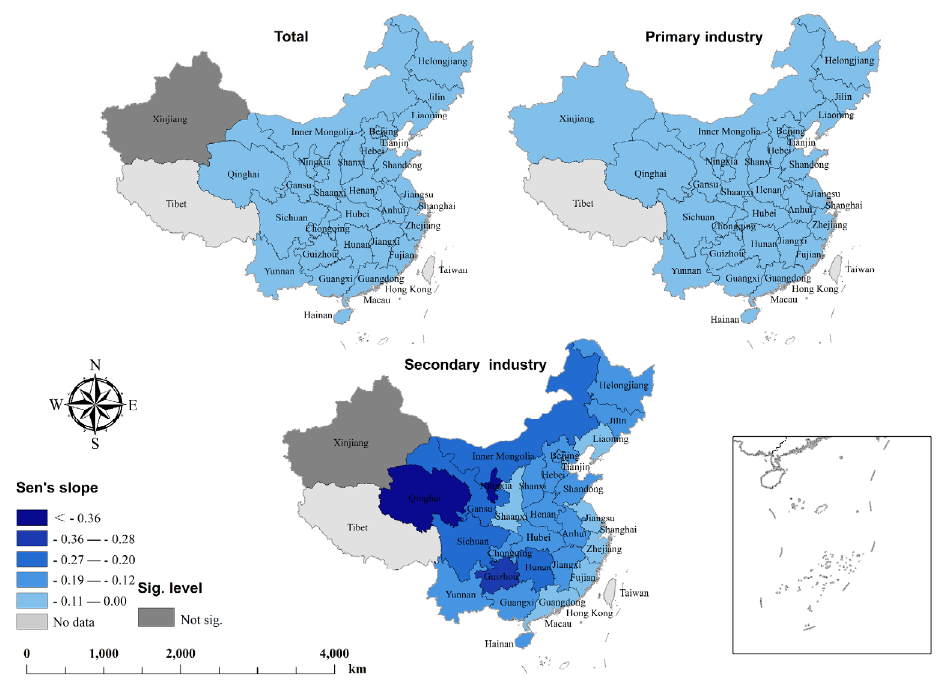
Figure 3. The magnitude of each trend and its statistical significance with respect to China’s provincial energy consumption intensity (ECI, t/10 4 RMB) during the 2005 to 2015 period. Data are available in Tables